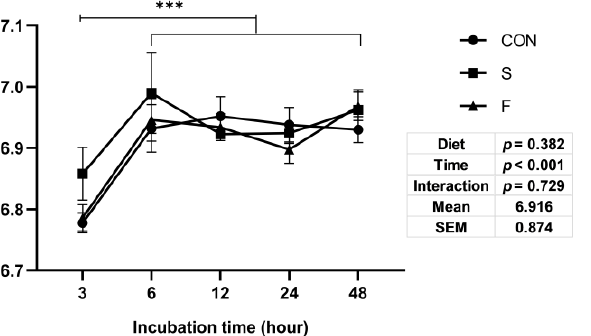
Figure 2. Effects of different oilseed treatments on in vitro pH. The X-axis represents the incubation time (hour). Y-axis represents the IVDMD value. CON: Control group, S: Raw whole soybean treatment, F: Raw flaxseed treatment. Diet: Diet treatment effects, Time: Incubation time effects, Interaction: The interaction effects between diet treatment and incubation time. ***: p < 0.01, means the culture fluids pH of incubation time 3 was significantly lower than other incubation times. Data are shown as the mean ± SEM, n = 6. Table 2. Effects of oilseed treatments on in vitro VFA concentration and N